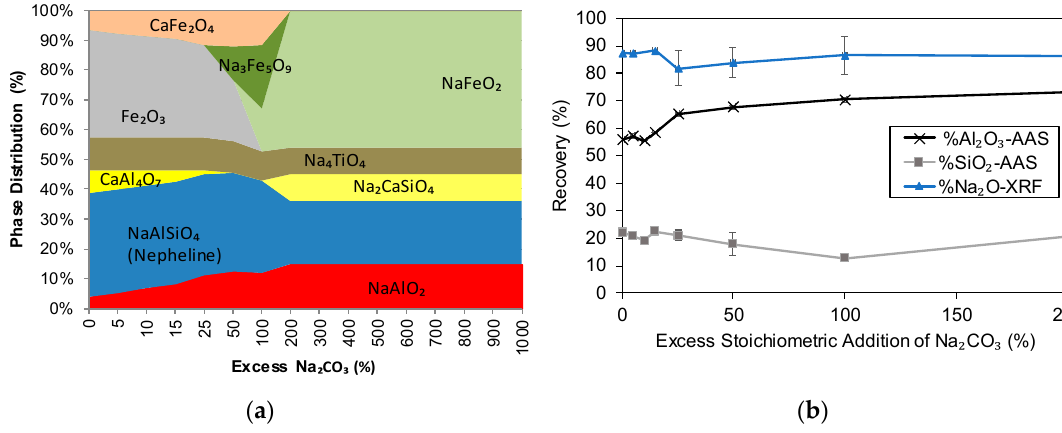
Figure 8. ( a ) Thermodynamic predictions of sinter phase formation and ( b ) results of experimental recovery of Al 2 O 3 , SiO 2 , and Na 2 O at the range of excesses of stoichiometric Na 2 CO 3 additions at 900 °C for 2 h.